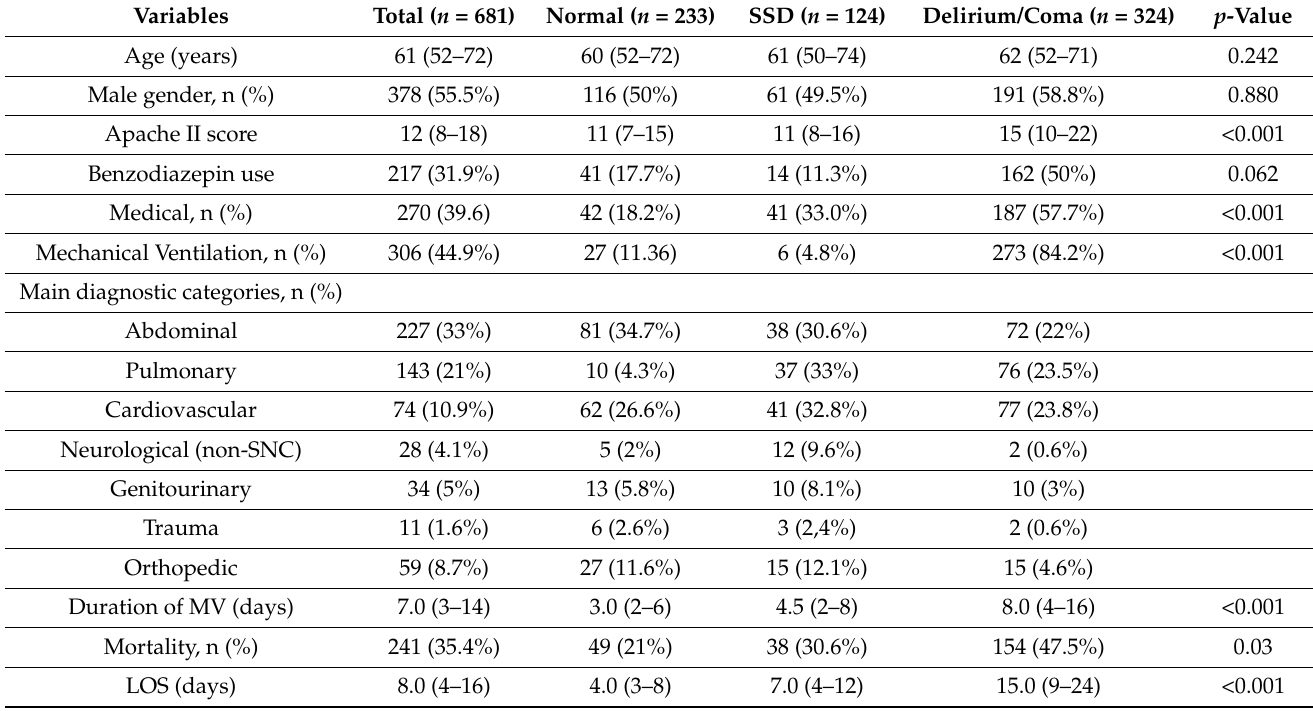
Table 1. Demographic and clinical variables of patients according to the worse mental status in the first 72